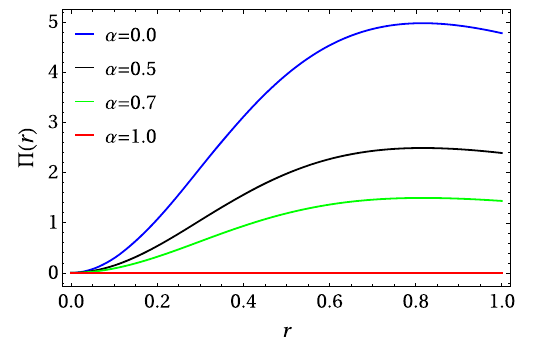
Fig. 2 Isotropization: total anisotropy [ (cid:10) × 10 3 ] for different values of the parameter α for a distribution with compactness M / R = 0 .